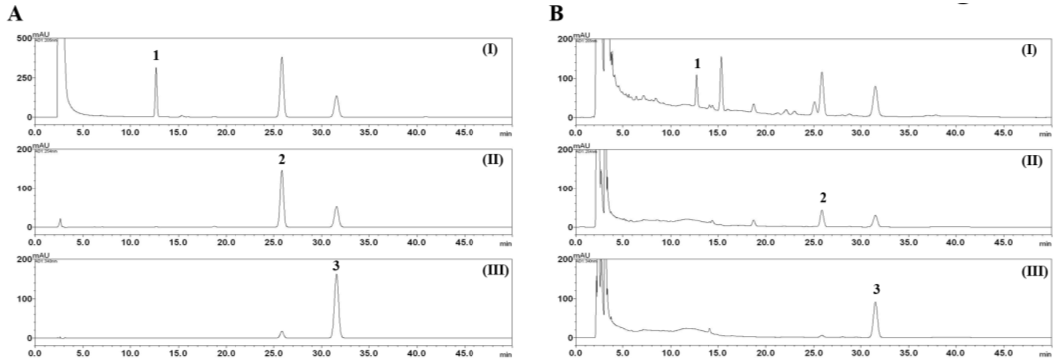
Figure 2. Quantitative analysis of the three marker compounds of ethanol extract of E. rutaecarpa (EEER). HPLC chromatograms of the standard mixture ( A ) and EEER ( B ) at a UV wavelength of 205 nm (I), 254 nm (II), and 340 nm (III). Rutaevin ( 1 ), evodiamine ( 2 ), and rutaecarpine ( 3 ).